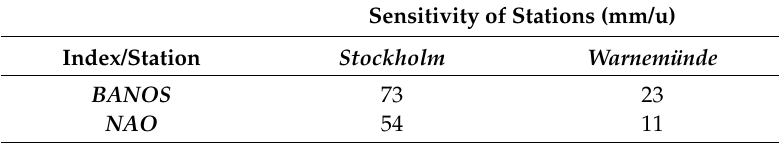
Table 3. The sensitivity values of sea level are estimated per one unit change in the associated index. For the estimation, a linear regression is implemented where sea level is the predictand and atmospheric index is the predictor. Time series are detrended prior to the sensitivity